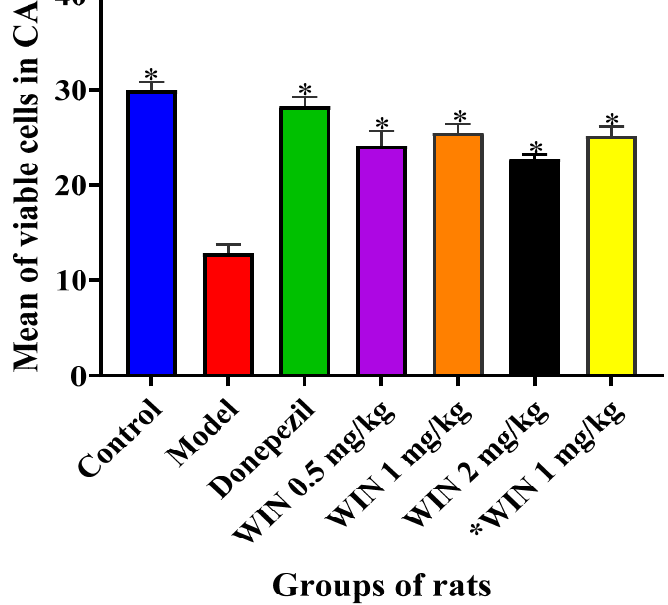
Figure 5. Significant differences in the number of viable cells counted in all the sub-fields of the hippocampus. The experimental groups include, control = normal saline + distilled water, Model (AlCl 3 200 mg/kg + D -gal 60 mg/kg), Donepezil (model + D -gal 60 mg/kg + Donepezil 1 mg/kg), WIN 0.5 mg/kg (model + WIN55,212-2 0.5 mg/kg), WIN 1 mg/kg (model + WIN55,212-2 1 mg/kg), WIN 2 mg/kg) (model + WIN55,212-2 2 mg/kg) and *WIN 1 mg/kg (model + WIN55,212-2 1 mg/kg).